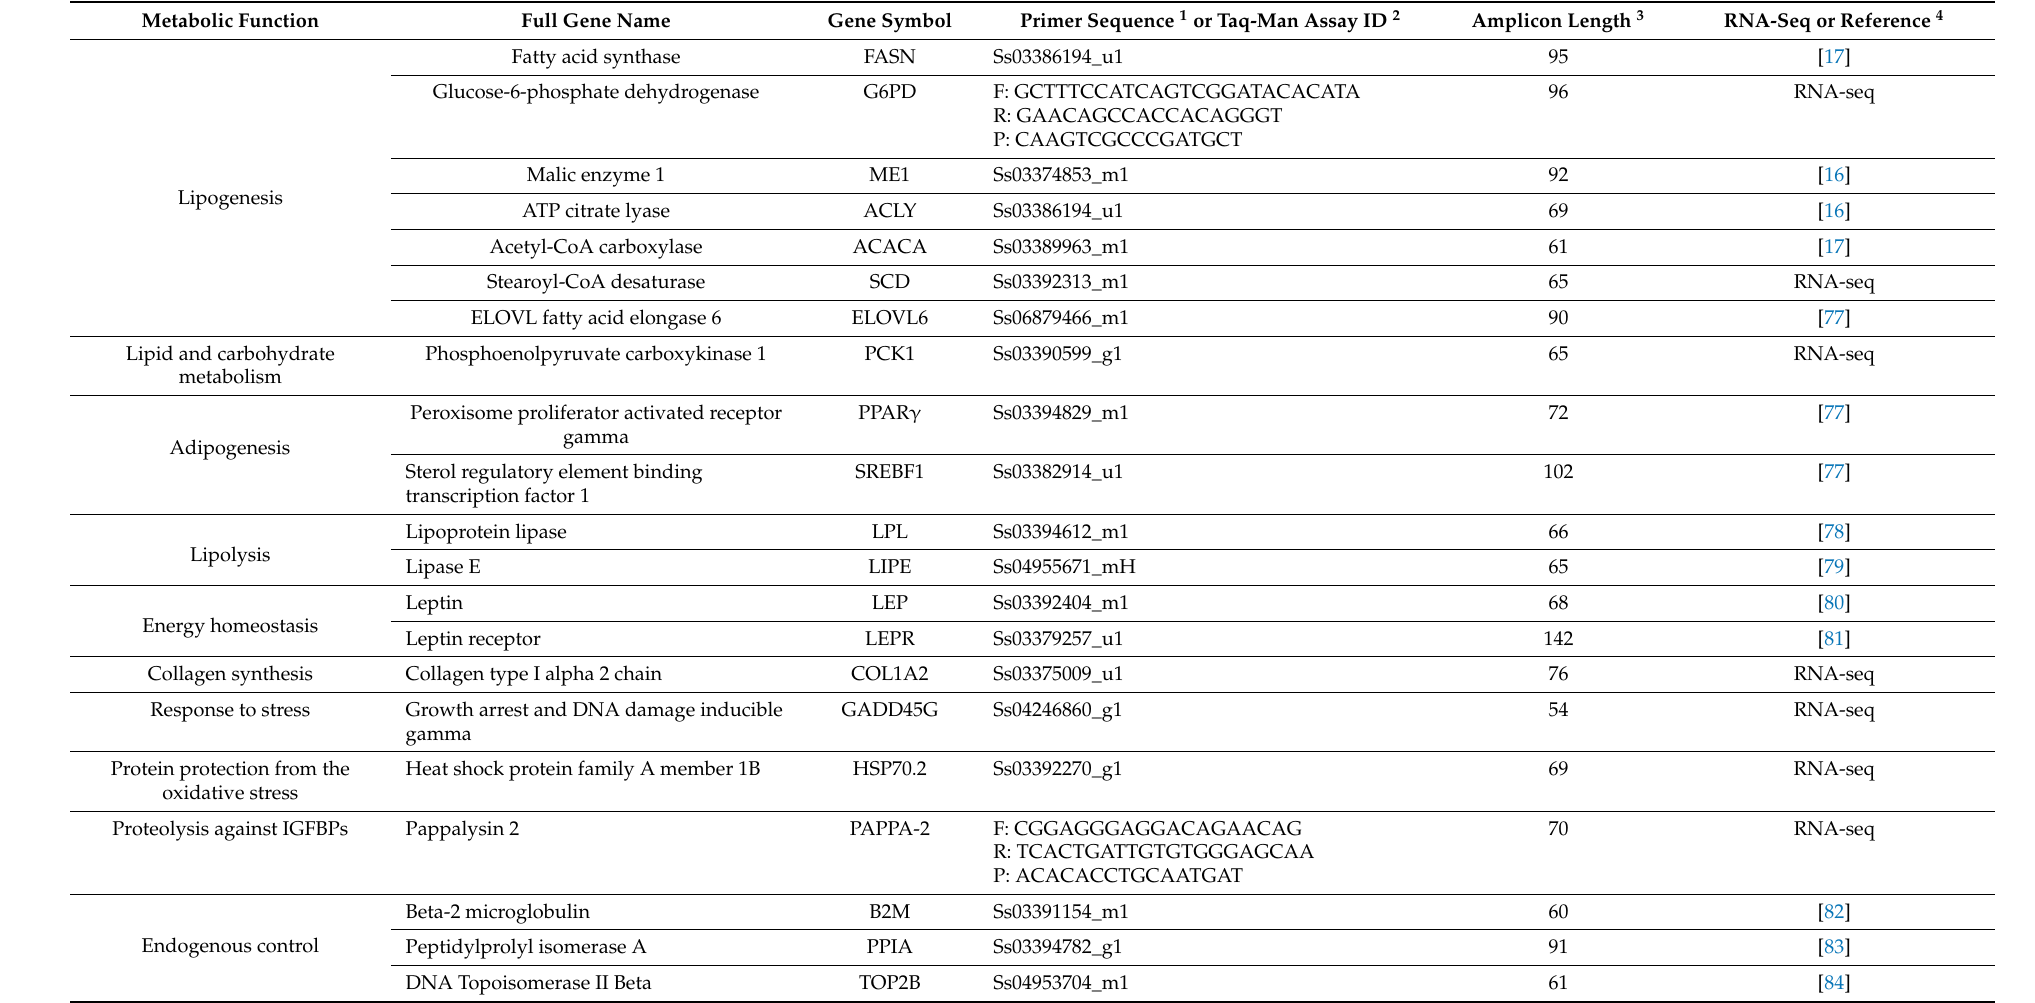
Table 1. Taq-man probes/primers with corresponding metabolic functions used in the